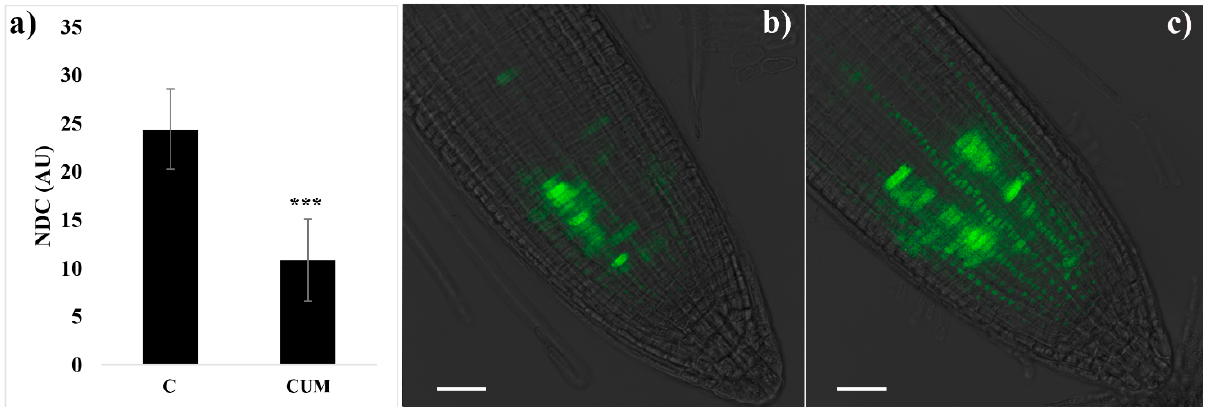
Figure 4. Effects of coumarin 0 (C) or 100 (CUM) µM on cell division in 4 days old Arabidopsis thaliana RAM. ( a ) Mitotic index expressed as the number of dividing cells (NDC). Data are presented as mean ± standard deviation (SD). Statistical analysis was performed using the Student’s t -test with *** p ≤ 0.001. N = 20. ( b , c ) Confocal microscopy imaging of Arabidosis transgenic line cyclin B1;1::GFP in control ( b ) and treated ( c ) RAM. Scalebar 50 µm.